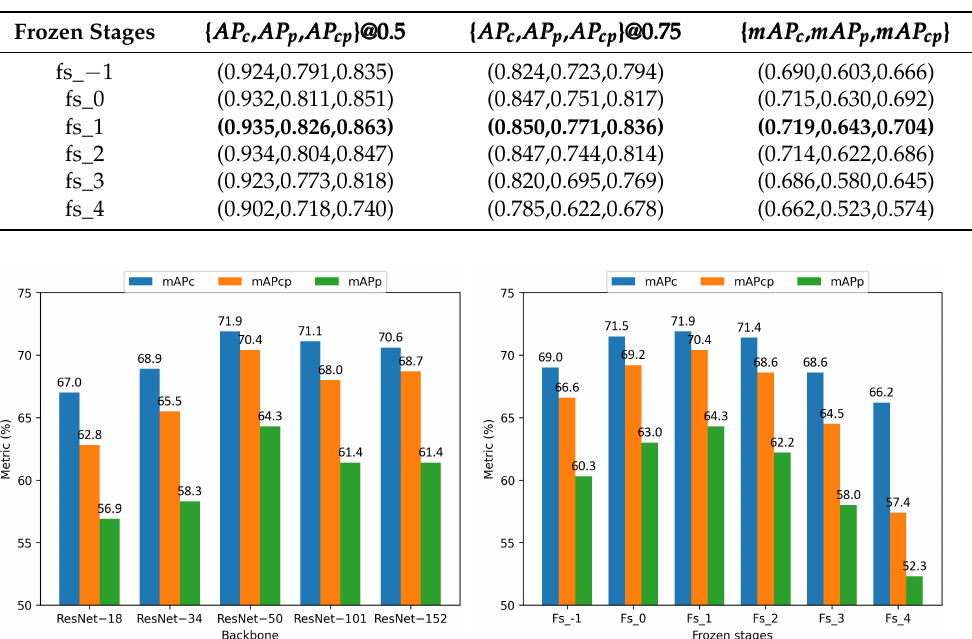
Table 6. Illustration of how the AP metrics of IPH-TOOD change with regard to the frozen_stages of the backbone network on the IPHPDT dataset.